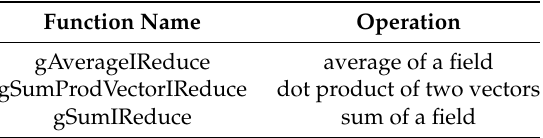
Table 5. Added global